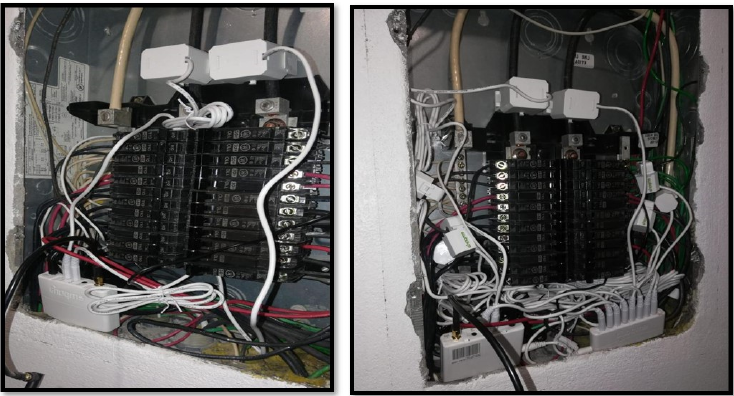
Figure 9. Installs in circuit panels of most split-phase 120 Vac homes with clamp-on